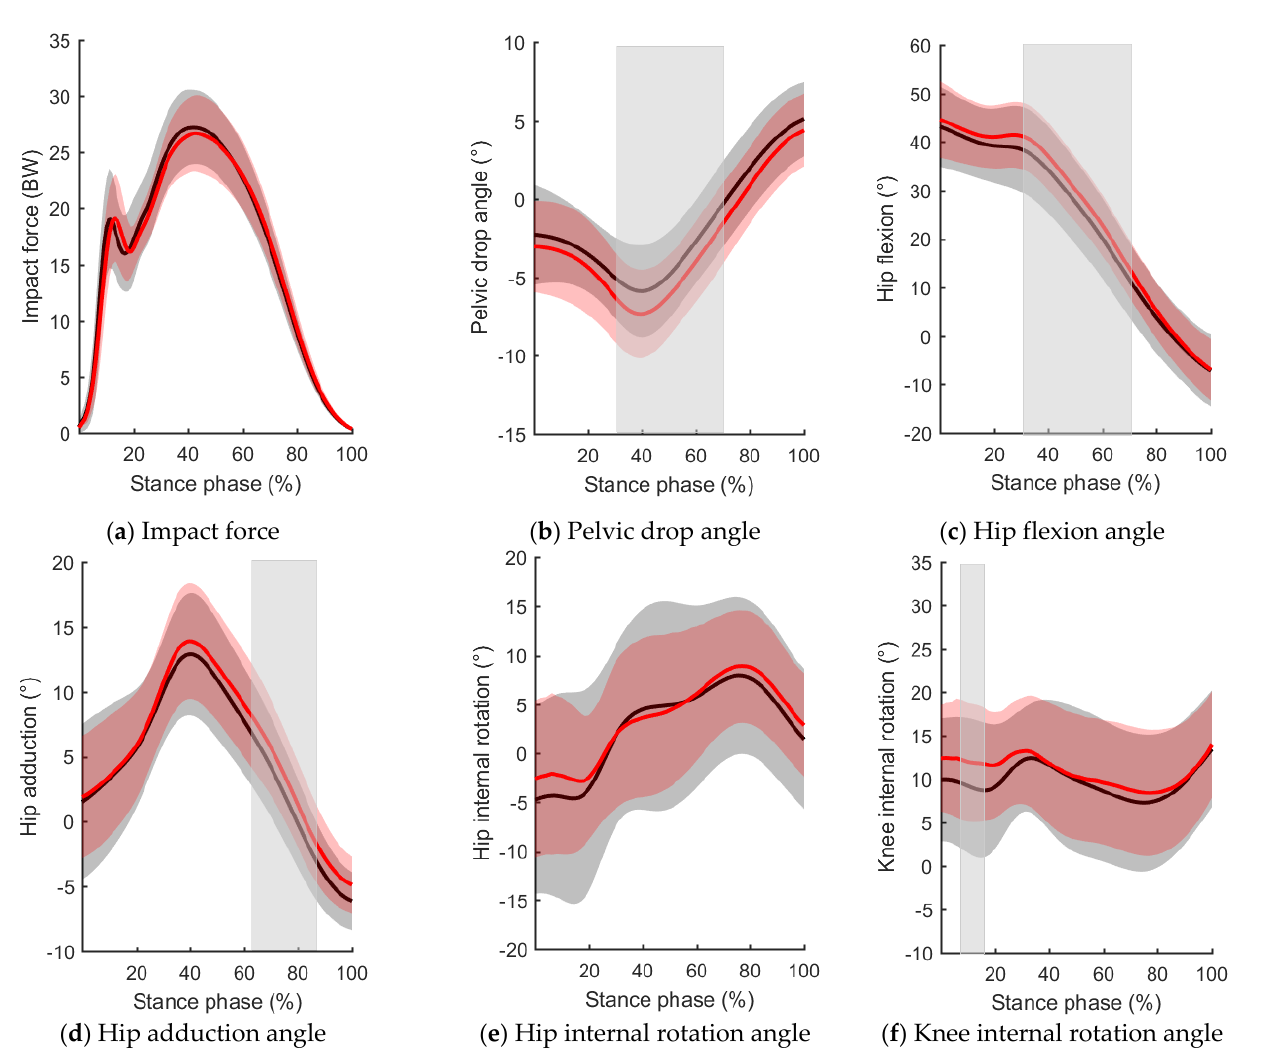
Figure 3. Comparison of impact force, hip kinematics, and knee internal rotation time series between flat shoes (black line) and conventional shoes with a 10 mm drop (red line): ( a ) impact force; ( b ) pelvic drop angle; ( c ) hip flexion angle; ( d ) hip adduction angle; ( e ) hip internal rotation angle; ( f ) knee internal rotation angle.